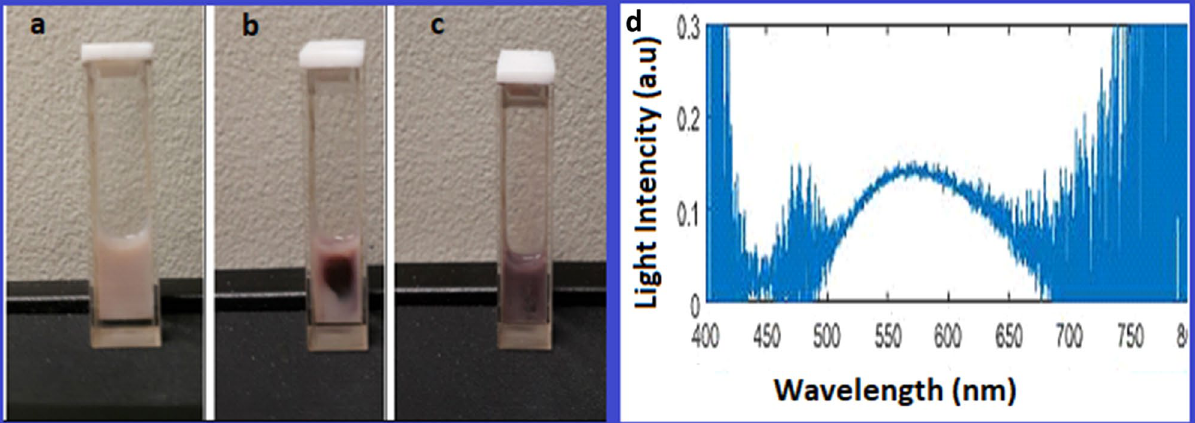
Figure 2. Illustration of soft wLED assisted formation of AgNPs@C_MA_O hydrogel. Nano silver formation in photosensitive hybrid hydrogel matrix was primarily confirmed by the visible color change. The colored ‘dot’ occurs in the center of the spot of wLEd during first minutes of irradiation, then color changes over the cuvette volume due to the irradiation temperature gradient (a) before wLEd exposure, (b) after 5 min and (c) after 25 min of wLED irradiation. (d) shows the scattering light spectra under influence of wLED .